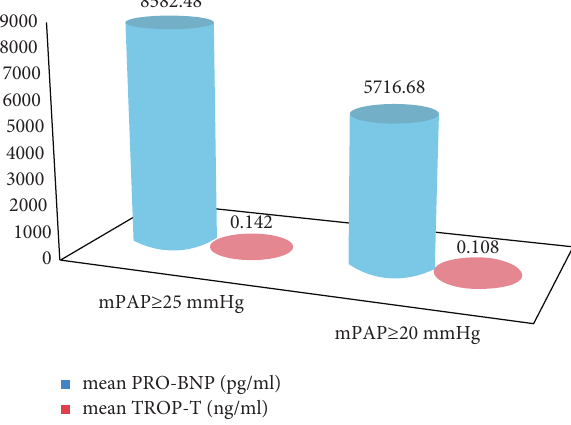
Figure 2: Mean pro-BNP and Trop-T values compared in the two